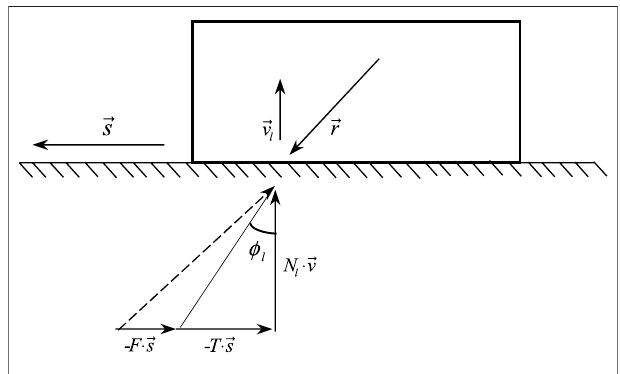
FIGURE 1 | The force analysis of a block.